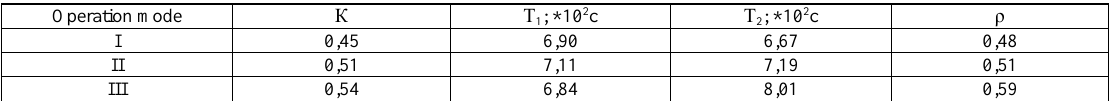
Table 4. The values of the transfer functionscoefficients for the three modes of operation of the pre- cleanerby the “grainsupply – efficiency”